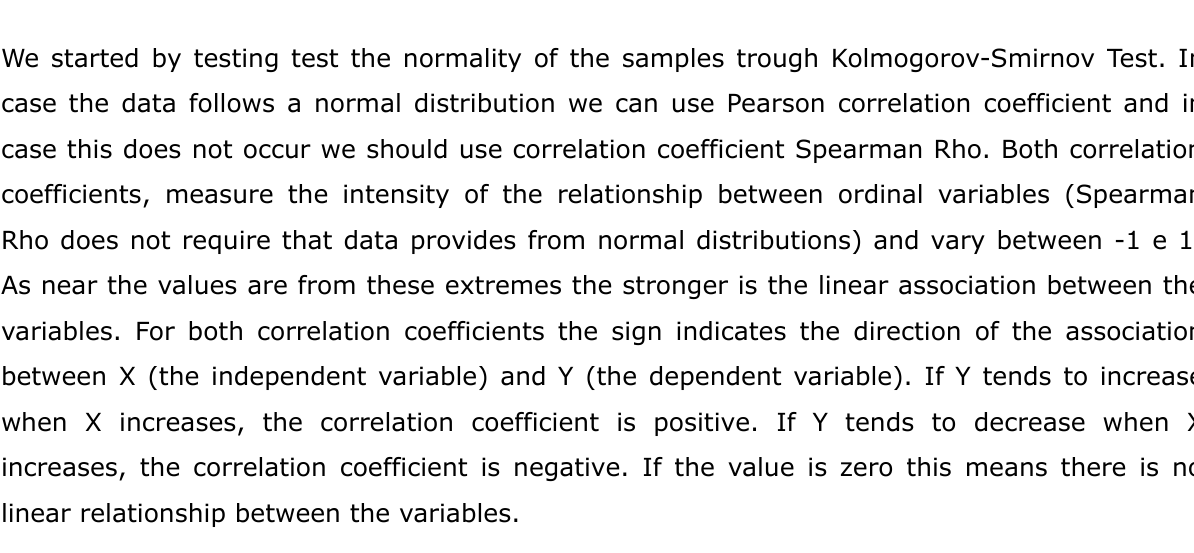
Ho: the variables follow normal distributions.